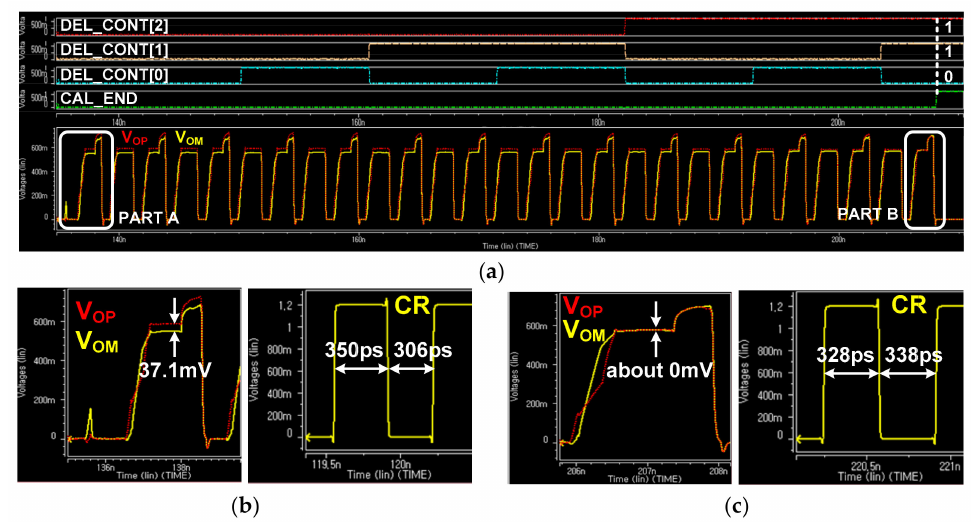
Figure 11. Simulation results of ALDE for pre-determined data: ( a ) Output waveforms of current in- tegrator and output codes of DDTJC; ( b ) Waveforms of V OP , V OM , and CR in PART A; ( c ) Waveforms of V OP , V OM , and CR in PART B.